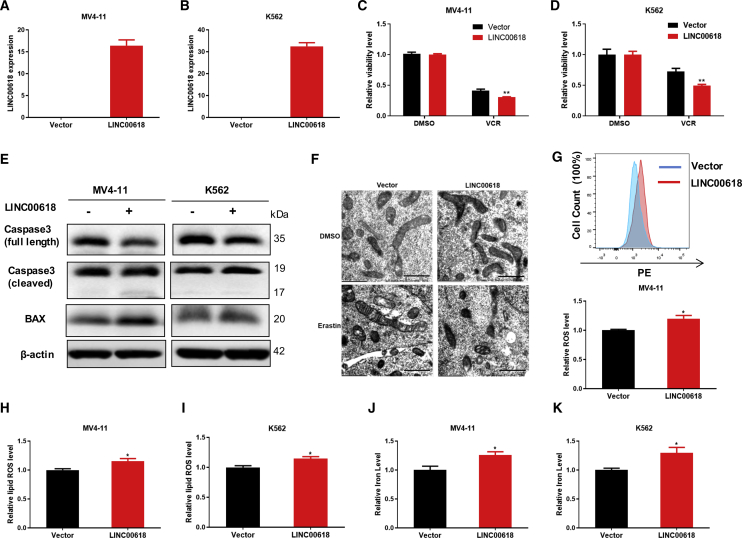
Overexpression of LINC00618 Promotes Cell Apoptosis and Ferroptosis(A) qRT-PCR analyses of stably expressing vector and LINC00618 in MV4-11 cells. (B) qRT-PCR analyses of stably expressing vector and LINC00618 in K562 cells. (C) Statistical analysis of the relative cell viability in MV4-11 cells stably overexpressing LINC00618 and treated by VCR at 48 h. DMSO served as control. (D) Statistical analysis of cell viability in K562 cells stably overexpressing LINC00618 and treated by VCR at 48 h. DMSO served as control. (E) Western blot analyses of caspase-3 and BAX protein level in K562 and MV4-11 cells stably overexpressing LINC00618. (F) Electron microscopy images of mitochondria in LINC00618-overexpressed K562 cell lines. Scale bars,1 μm. (G) FACS and statistical analysis of ROS level in MV4-11 cells stably overexpressing LINC00618. (H) FACS and statistical analysis of relative lipid ROS level in MV4-11 cells stably overexpressing LINC00618. (I) FACS and statistical analysis of relative lipid ROS level in K562 cells stably overexpressing LINC00618. (J) Relative iron level checked by an Iron Assay Kit in MV4-11 cells stably overexpressing LINC00618. (K) Relative iron level checked by an Iron Assay Kit in K562 cells stably overexpressing LINC00618. Data are shown as the mean ± SEM; n ≥ 3 independent experiments, two-tailed Student’s t test: ns, nonsignificant (p > 0.05), ∗p < 0.05, ∗∗p < 0.01, ∗∗∗p < 0.001.